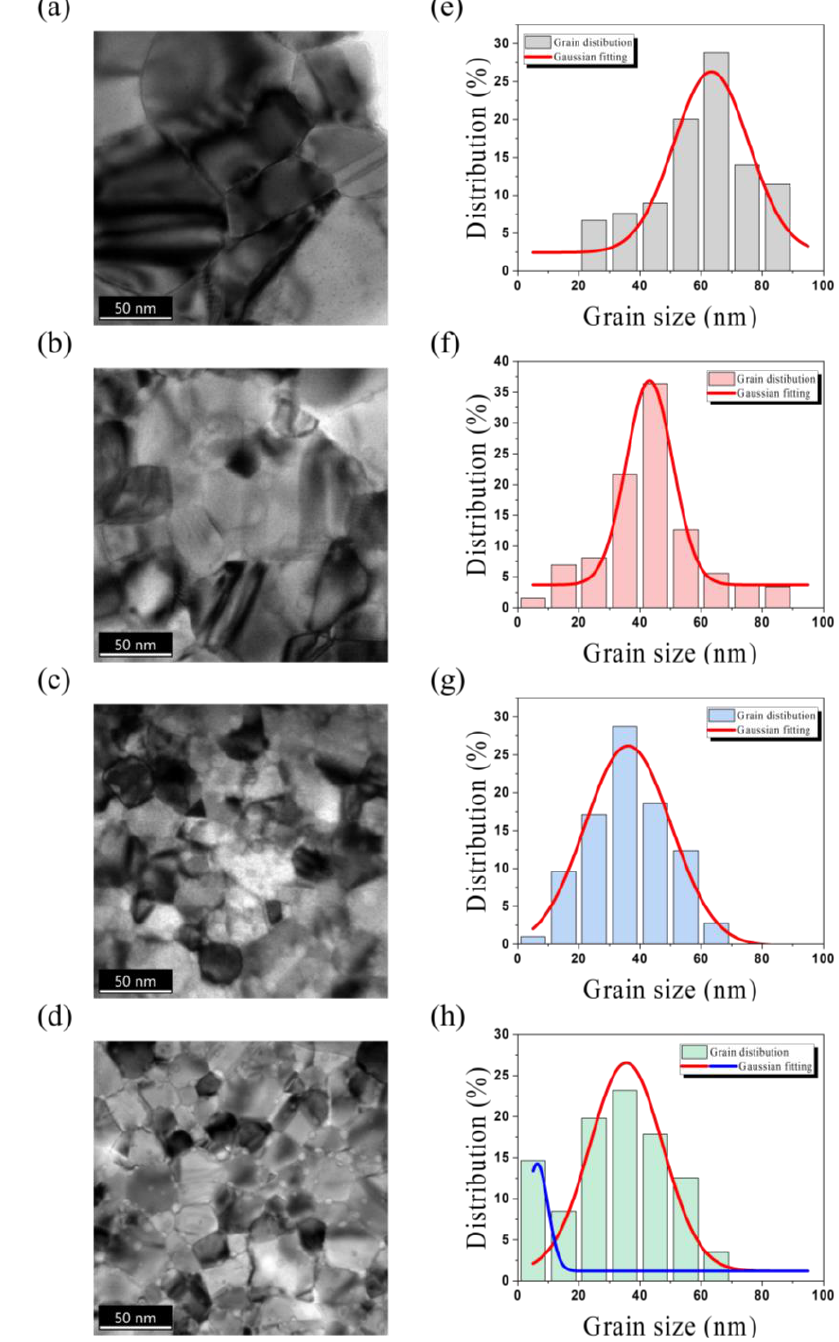
Figure 2. TEM images of Bi 1− x Gd x FeO 3 films: ( a ) x = 0.00, ( b ) 0.05, ( c ) 0.10, and ( d ) 0.15. Grain size distribution of the films: ( e ) x = 0, ( f ) 0.05, ( g ) 0.10, and ( h ) 0.15.